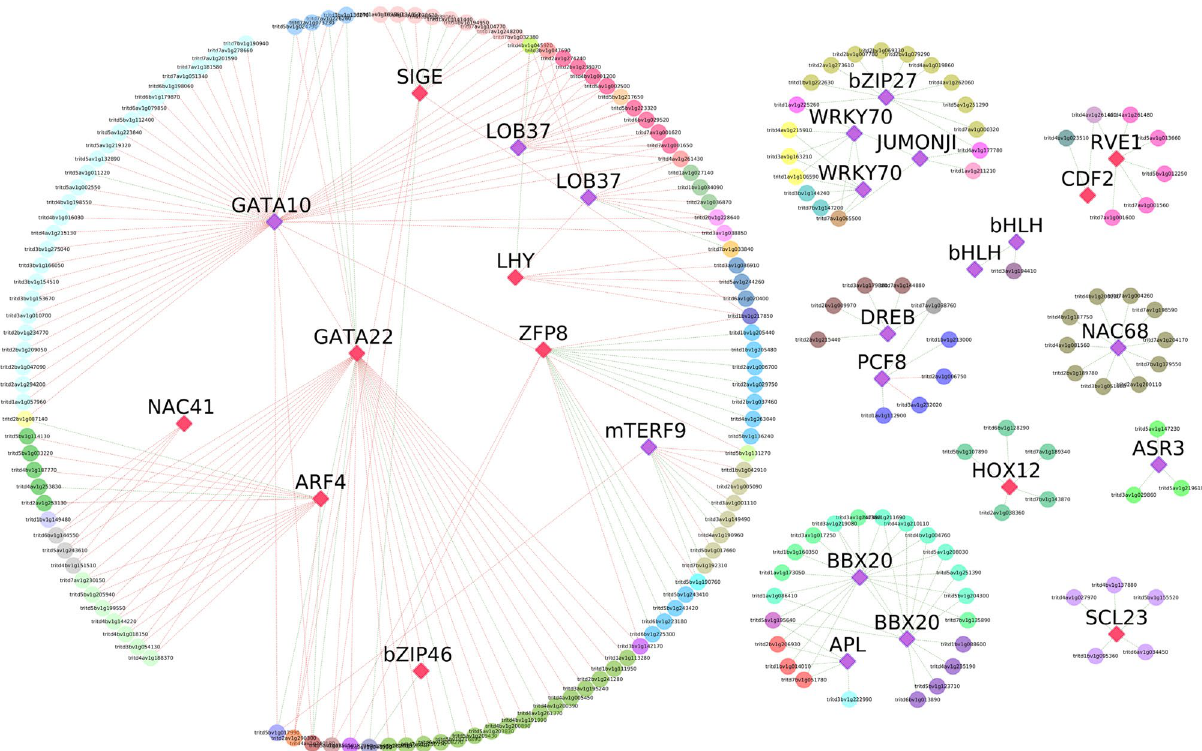
Figure 5. Co-expression network analyses of 30 Transcription Factors (TF) differentially expressed under salt stress as bait genes. The network was obtained with CoExpNetViz tool and visualized by Cytoscape. Bait TFs are represented as squared nodes. Colors represents downregulated TFs (red) and upregulated TFs (violet) while green and red lines denote positive correlation and negative correlation, respectively. Nine sub-networks are present, with the bigger one including 122 genes and 11